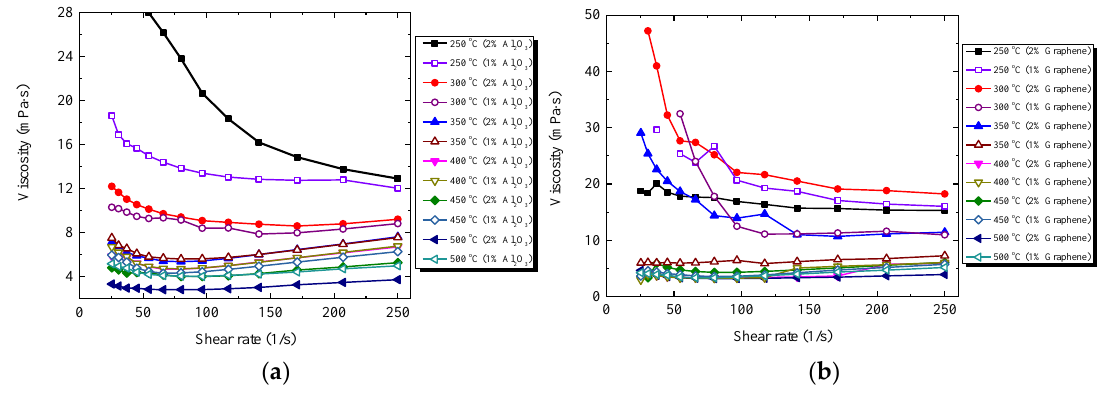
Figure 8. Viscosities of nanocomposites against different shear rates. ( a ) HITEC salt seeded with Al 2 O 3 nanopowder, ( b ) HITEC salt seeded with graphene. The addition of Al 2 O 3 nanopowder and graphene is with mass weight percentage.